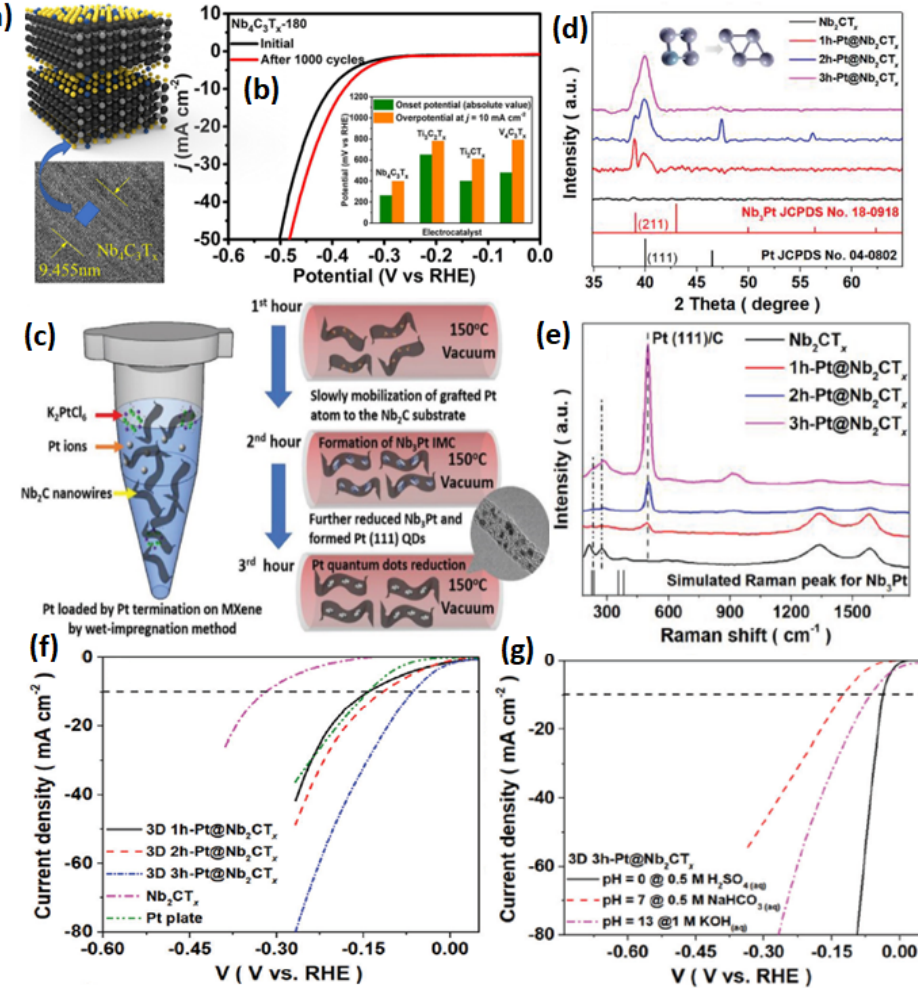
Figure 10. ( a ) Schematic of Nb4C3Tx. ( b ) Polarization curves of the Nb4C3Tx-180 electrode before and after 1000 cycles at 100 mV s-1 under an alkaline onset potential and overpotential at j @ 10 mA cm-2 in different MXenes conditions (Reprinted with permission from Ref. [91]. Copyright 2021, Elsevier) ( c ) Schematic for the fabrication of Pt QDs on Nb2CTx NWs. ( b , c ) Structural investigation of various Pt QDs on MXene by their ( d ) XRD patterns and ( e ) Raman spectra. ( f ) LSV for 3D Pt@Nb2CTx with different synthesis times ( g ) The LSV for 3D 3h-Pt@Nb 2 CTx in different electrolytes (Adapted from Ref. [92], Open access).